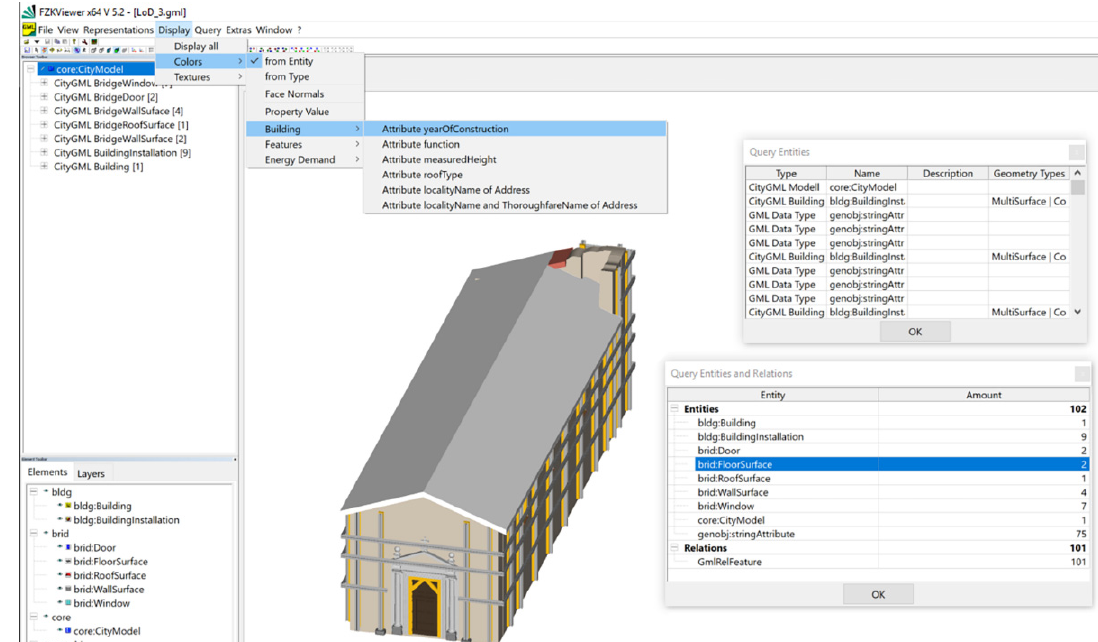
Figure 20. The 3D model CityGML file of the church visualised in the FZK Viewer.